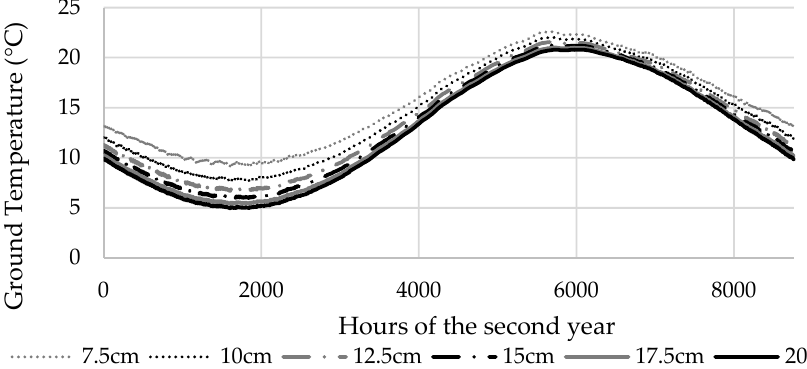
Figure 4. Ground temperature below the building in function of the insulation thickness on the bottom.